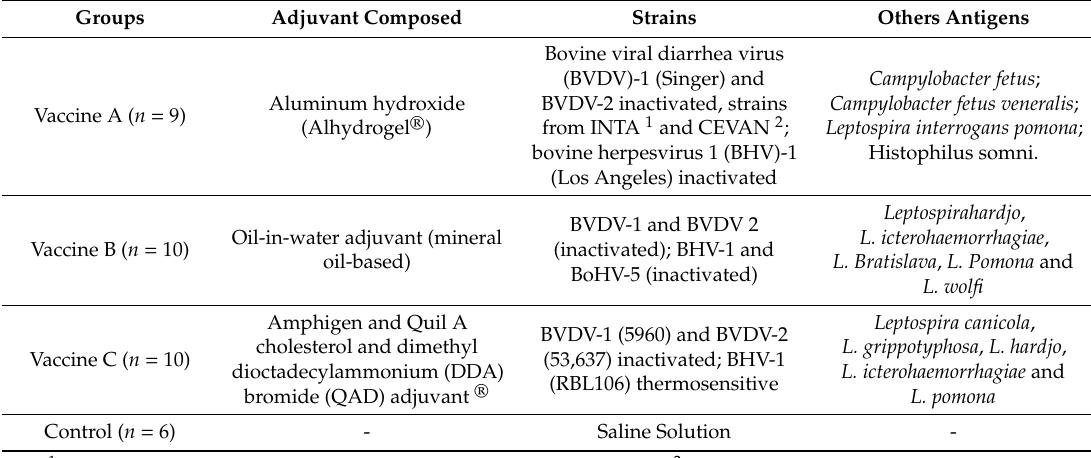
Table 1. Vaccine treatment groups and vaccine formulations.